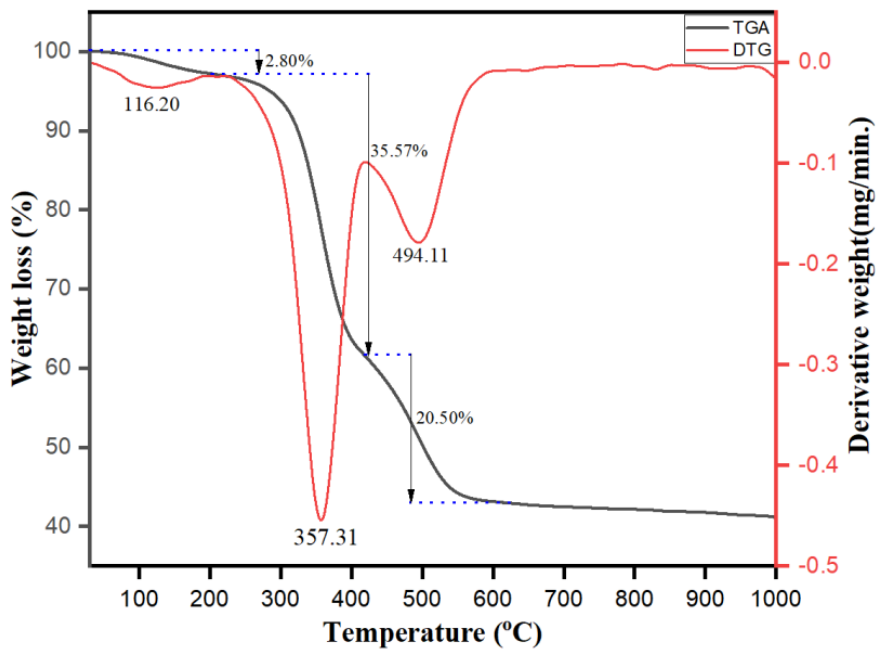
Figure 4. TGA-DTG curve representing thermal decomposition of Ag-Cu-Co trimetallic nanoparti- cles.